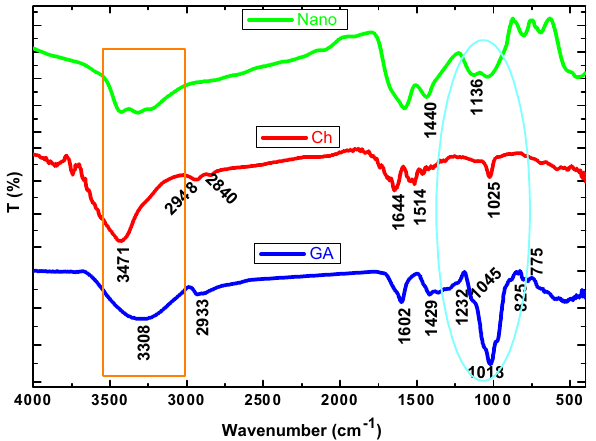
Figure 2. FT-IR of the prepared nanocomposite inhibitor and its two raw materials Ch and GA.